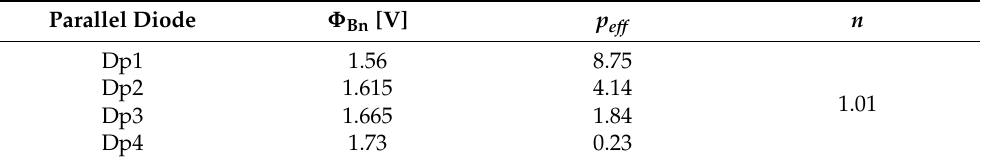
Table 1. Fitting parameters for sample S1.